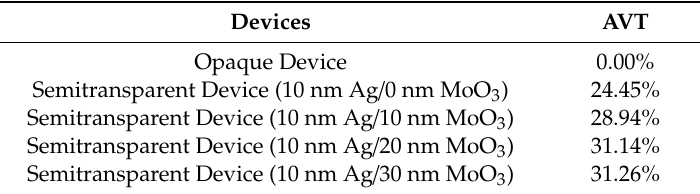
Table 2. The average visible transmittance (AVT) of the opaque and all fabricated semi-transparent devices with di ff erent thickness of the outer MoO 3